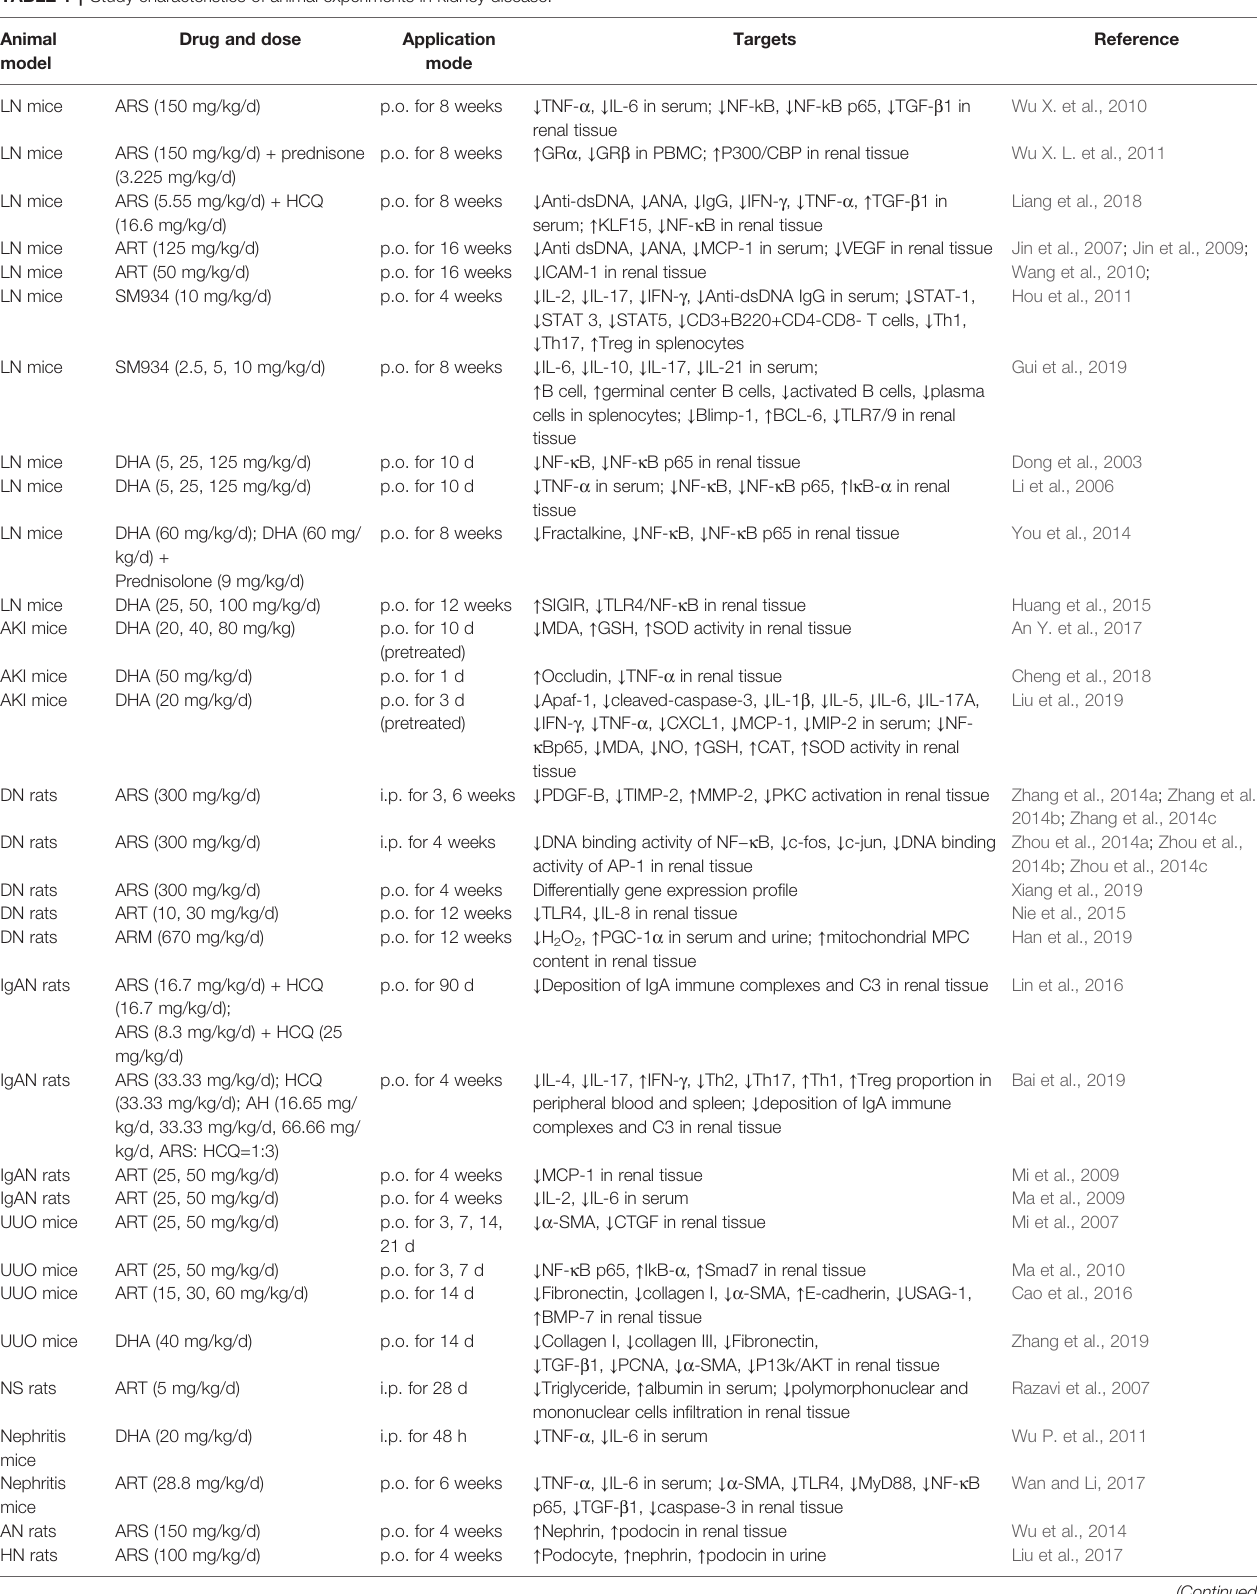
TABLE 1 | Study characteristics of animal experiments in kidney disease. Animal